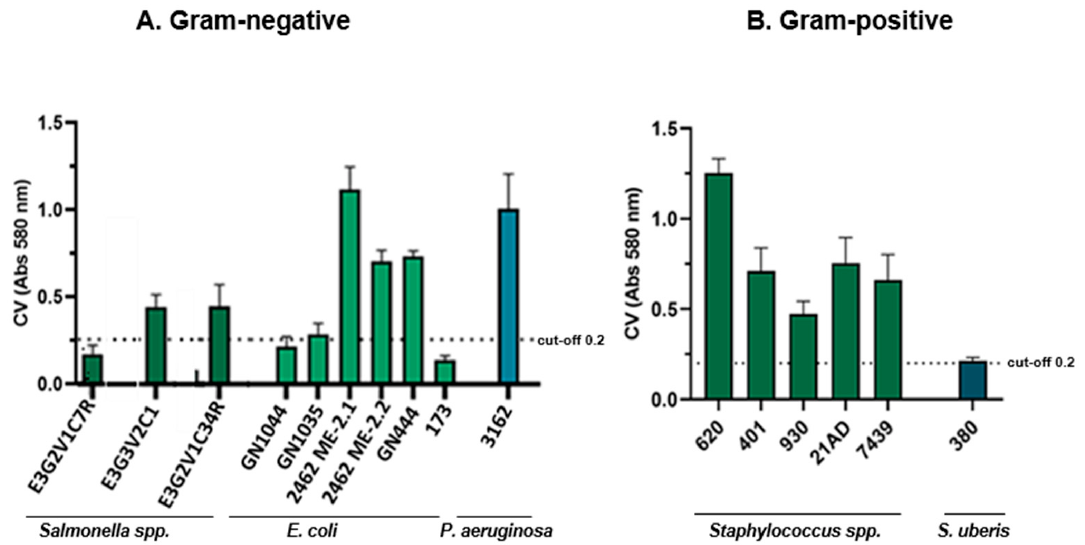
Figure 3. Results obtained after CV reading at 580 nm to identify biofilm-forming strains. Mean values of three readings are represented. ( A ) Gram negative strains. ( B ) Gram-positive bacteria.